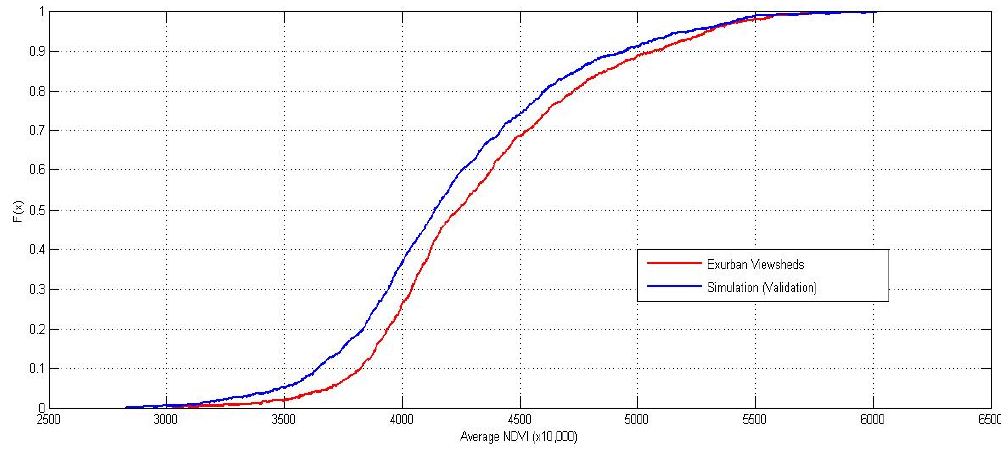
Figure 4. Cumulative distribution functions of average NDVI values for actual exurban and simulated (validation)